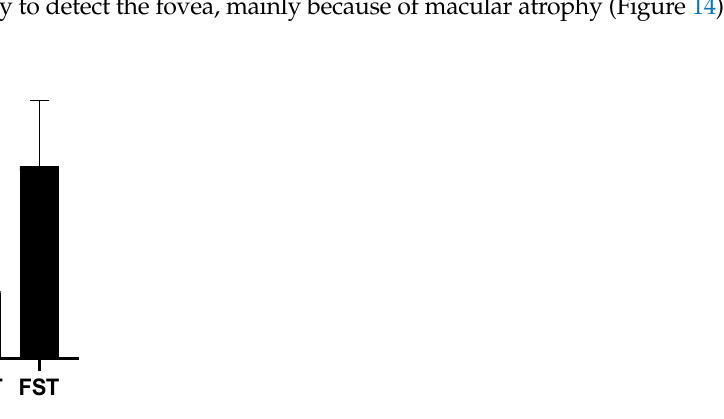
Figure 14. Retina, choroidal, and scleral foveal thicknesses. FRT = foveal retinal thickness; FCT = foveal choroidal thickness; FST = foveal scleral thickness. Only 132 eyes were evaluated to measure the FAZ and its perimeter due to segmen- tation errors at the superficial plexus and 127 for the deep plexus. The results from those eyes are shown in Figure 15.